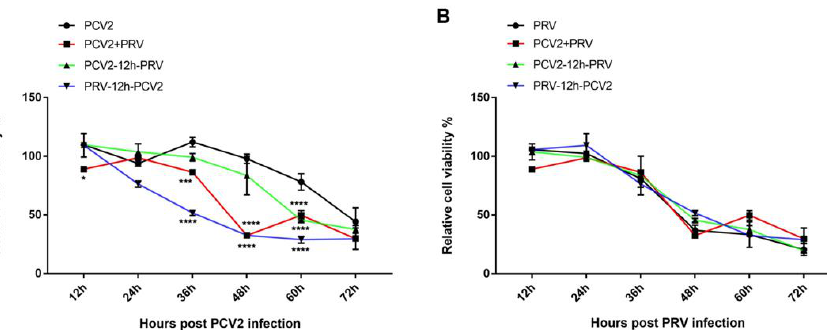
Figure 2. Cell viability of PCV2 ( A ) and PRV ( B ) in different infection groups. PK-15 cells were infected with different combinations of PCV2 and/or PRV for 12, 24, 36, 48, 60, and 72 h, and then the cell viability was evaluated by CCK8 at indicated hours after the indicated virus infection. *, p -value < 0.05; ***, p -value < 0.001; ****, p -value < 0.0001.